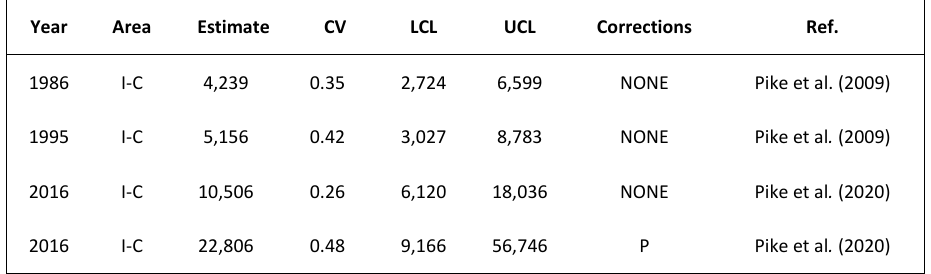
Table 5. Summary of further abundance estimates for harbour porpoises in Iceland (I-C=Icelandic coastal) from aerial surveys (altitude 750 ft). Corrections, P=perception